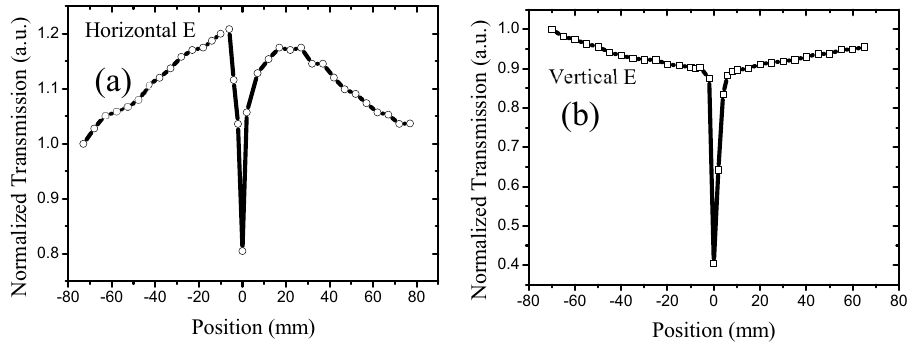
Figure 4. Z-scan results of GO in DI water. 527-nm laser with 50 mW power; transmission of graphene suspension is 10%; cuvette is 5 mm wide.